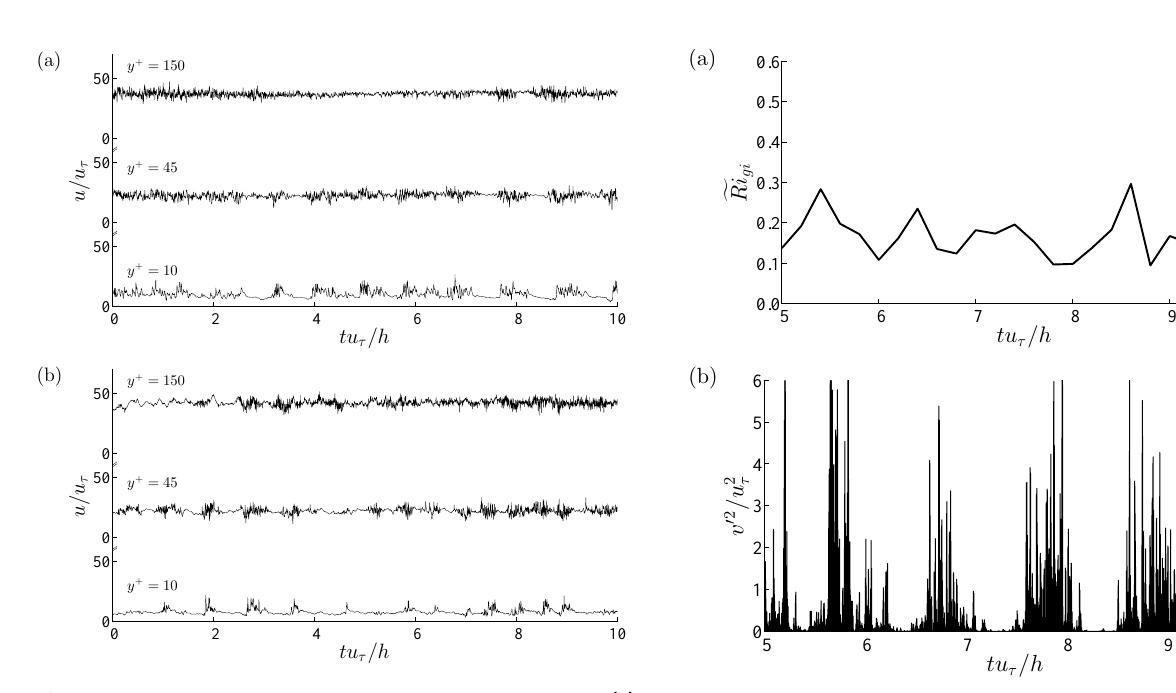
Figure 23. Time series of (a) f Ri gi and (b) v (cid:48) 2 at y + = 90 ( Re τ = 395, Ri τ =